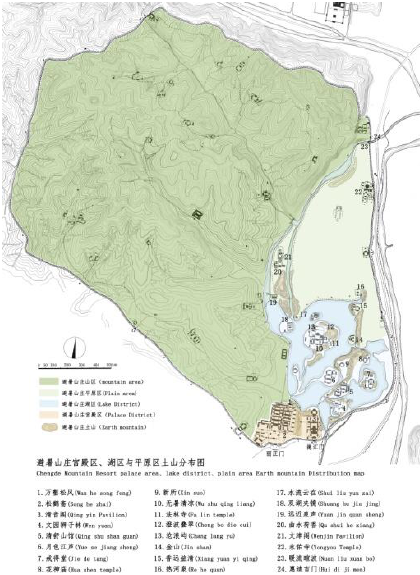
Figure 3 . Distribution map of artificial earth mountain in Mountain Resort.(From Wang